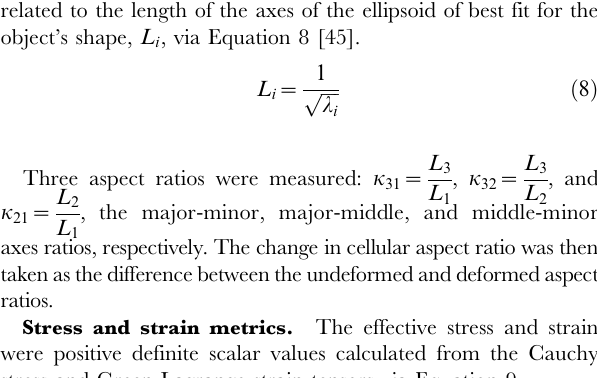
Figure 4. A cross-section of the 25889 finite element mesh of the single cell micro-scale case, which was determined to be mesh-converged. The extracellular matrix (ECM), pericellular matrix (PCM), and chondrocyte (Cell) were discretized with linear hexahedral elements. The chondrocyte had 9 elements across its diameter and the pericellular matrix had 2 elements through its thickness. For the eleven cell case, the chondrocyte and pericellular matrix had the same mesh